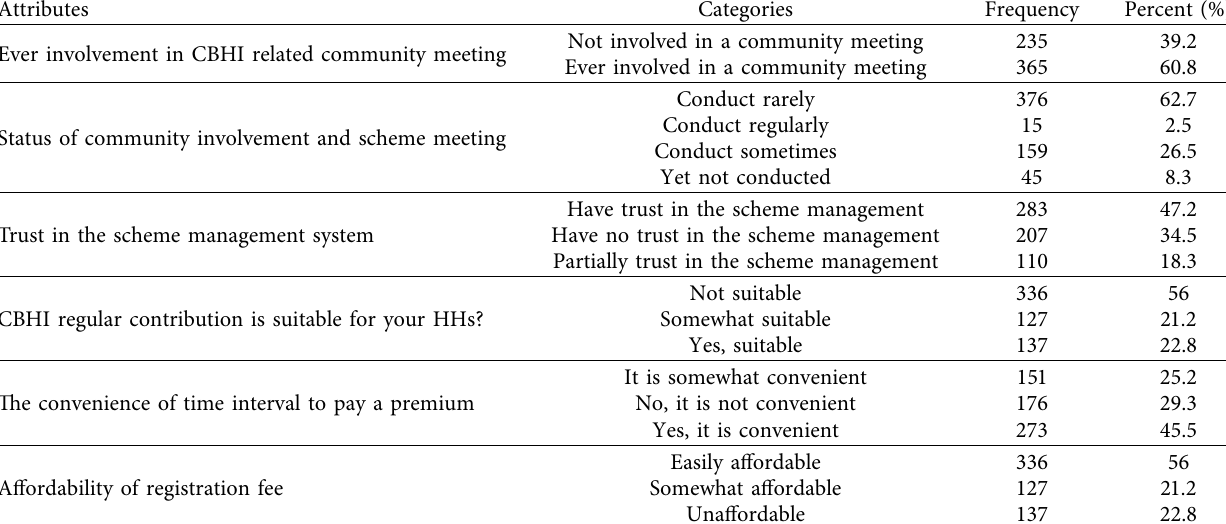
Table 3: Scheme related factors associated with CBHI.